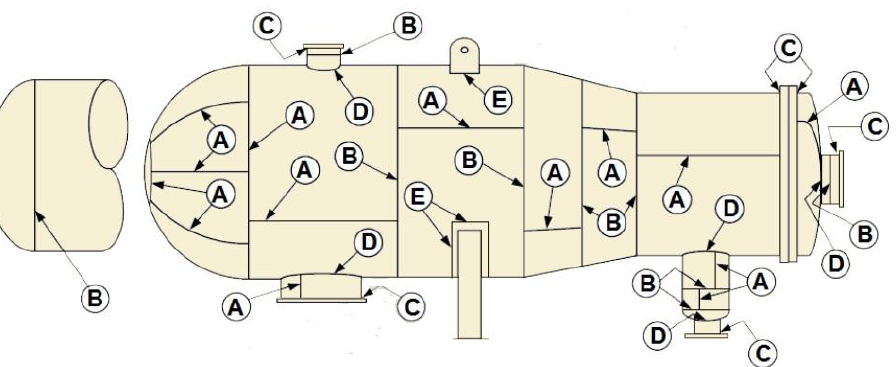
longitudinal or spiral welds in the main shell. Category B is for circumferential welds in the main connecting nozzles or chambers to the main